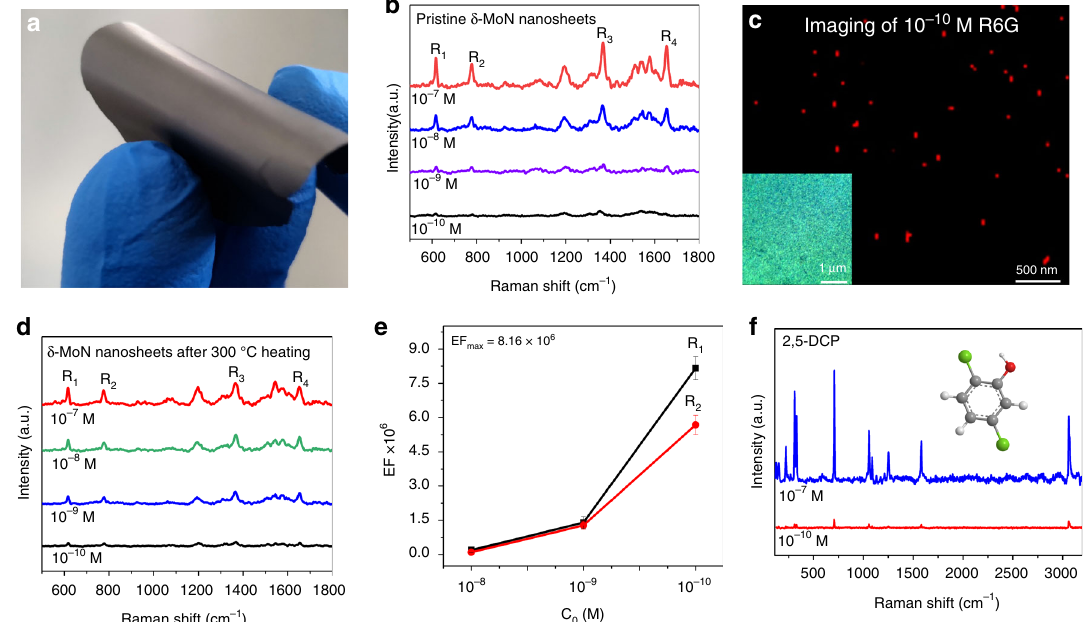
Fig. 7 SERS properties of the δ − MoN nanosheets. a Flexible SERS substrate assembled with the δ − MoN nanosheets. b Raman spectra of 10 − 7 – 10 − 10 M R6G obtained in the fl exible δ − MoN substrate. c SERS imaging recorded from 10 − 10 M R6G over the δ − MoN substrate, inset: an optical photo of the selected area. d Raman spectra of R6G recorded on the δ − MoN substrate after 300 °C heat treatment. e The average Raman EFs obtained by counting the peak intensities (R 1 and R 2 ) at three different concentration levels. f Raman spectra of 2,5-DCP obtained in the fl exible δ − MoN nanosheet